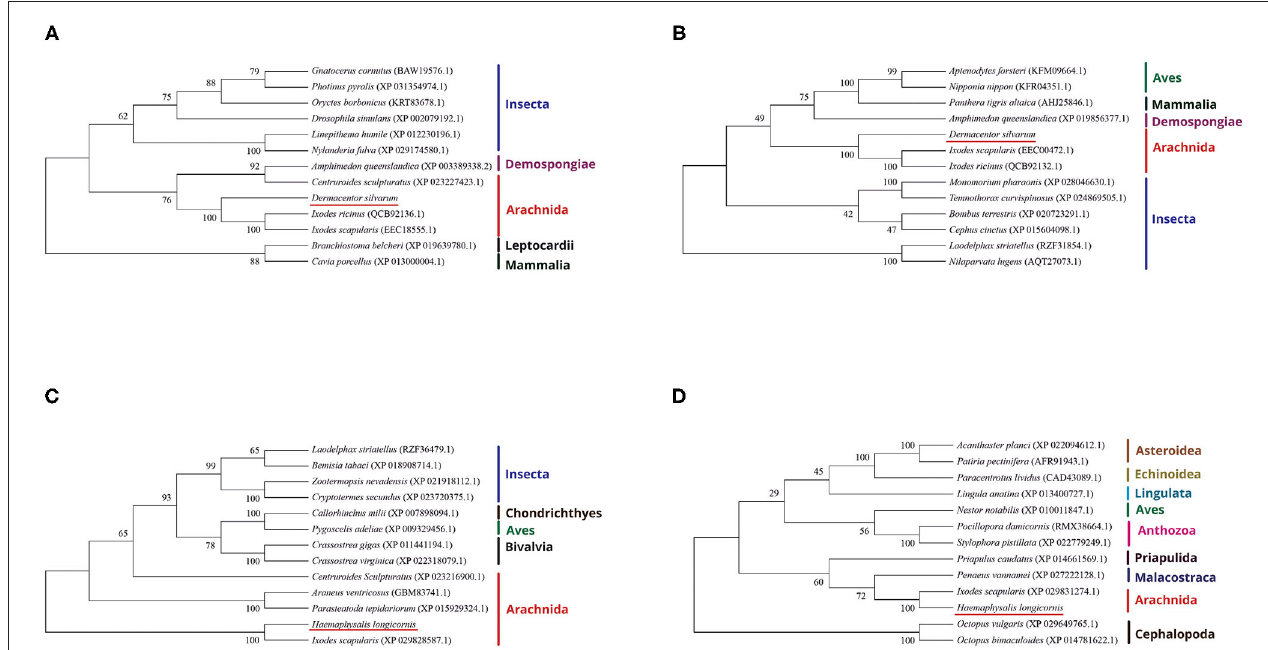
FIGURE 1 | Phylogenetic reconstruction of DNA methyltransferases based on the neighbor-joining method. The listed species are colored according to their classification to particular taxonomic classes. (A) Illustration of the phylogenetic relationship of DsDnmt sequences to Dnmts of other species; (B) Illustration of the phylogenetic relationship of DsDnmt1 sequences to Dnmts of other species; (C) Illustration of the phylogenetic relationship of HlDnmt1 sequences to Dnmts of other species; (D) Illustration of the phylogenetic relationship of HlDnmt sequences to Dnmts of other